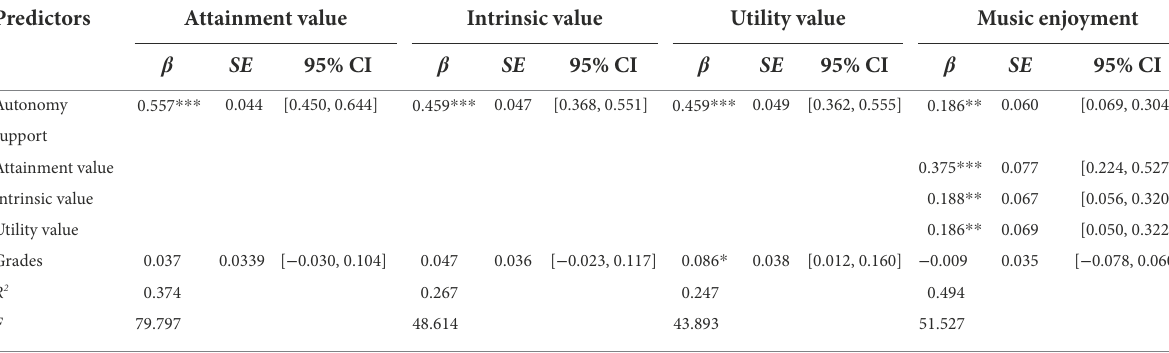
TABLE 3 Mediation model of music values between autonomy support and music enjoyment.